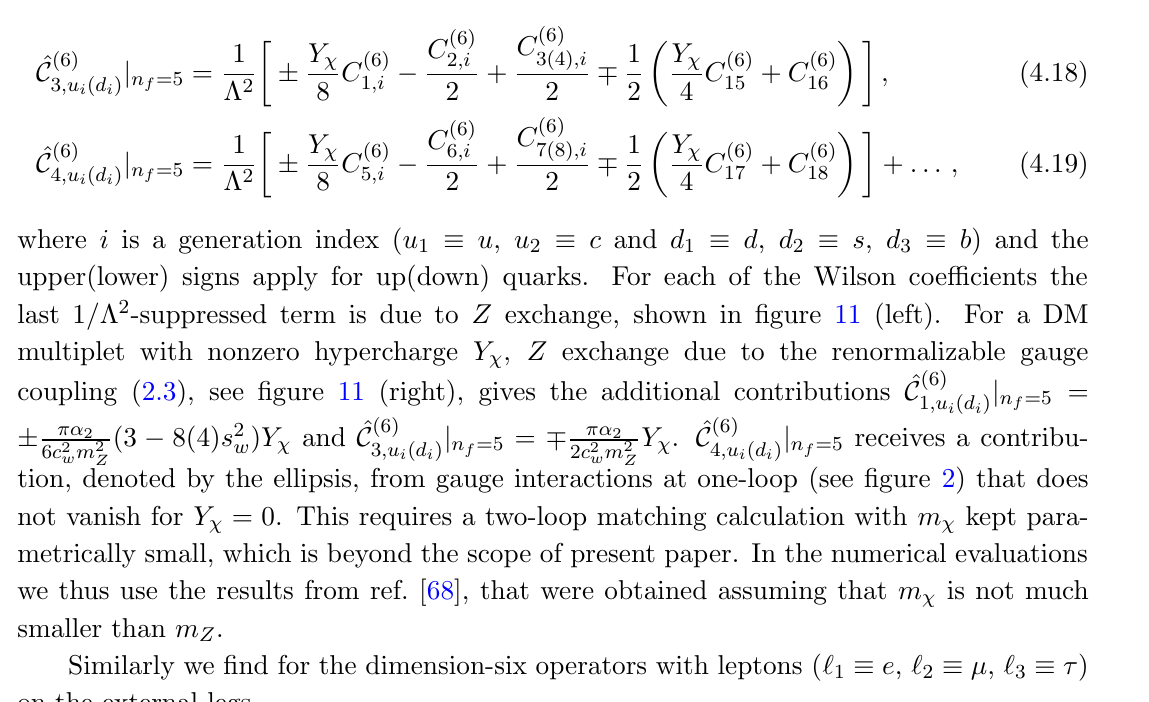
Figure 11 . Matching contributions to the e(cid:11)ective operators at (cid:22) the contribution of the high-energy operators, the middle one the contribution from the dimension- four gauge interactions onto the dimension-six operators, respectively; the right diagram shows the contribution to the matching onto the dimension-seven